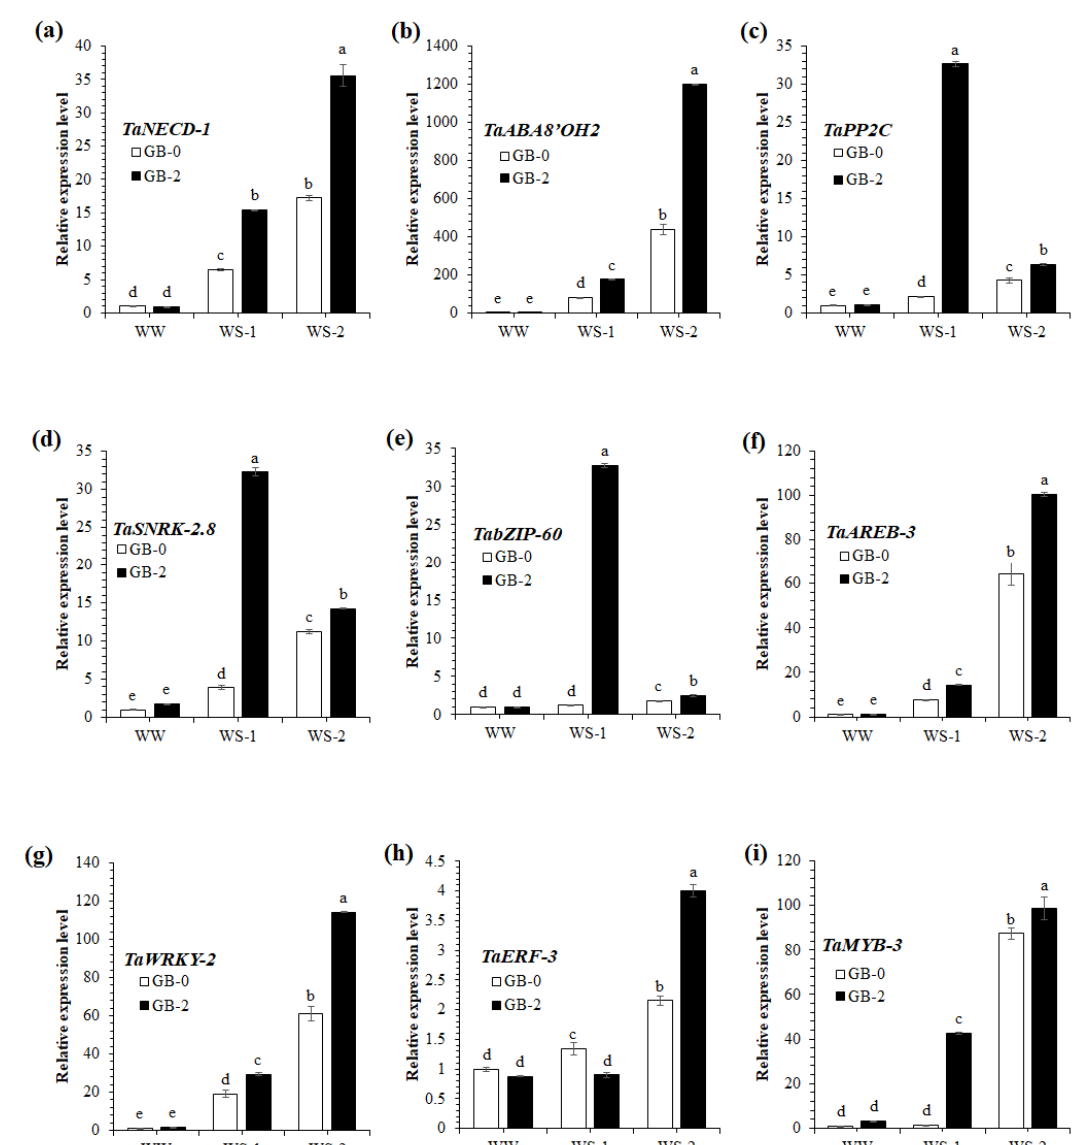
Figure 6. Effect of GB root ‐ priming on expression levels of TaNECD ‐ 1 ( a ), TaABA8 ′ OH2 ( b ), TaPP2C ( c ), TaSNRK ‐ 2.8 ( d ), TabZIP ‐ 60 ( e ), TaAREB ‐ 3 ( f ), TaWRKY ‐ 2 ( g ), TaERF ‐ 3 ( h ), and TaMYB ‐ 3 ( i ) in the roots of wheat seedlings in well ‐ water (WW), after 24 h water ‐ stress (WS ‐ 1) and after 48 h water ‐ stress (WS ‐ 2). Each value represents the mean ± standard deviation (SD) of three replicates. Bars showing different letters represent the significant differences at p ≤ 0.05 as determined by LSD test.